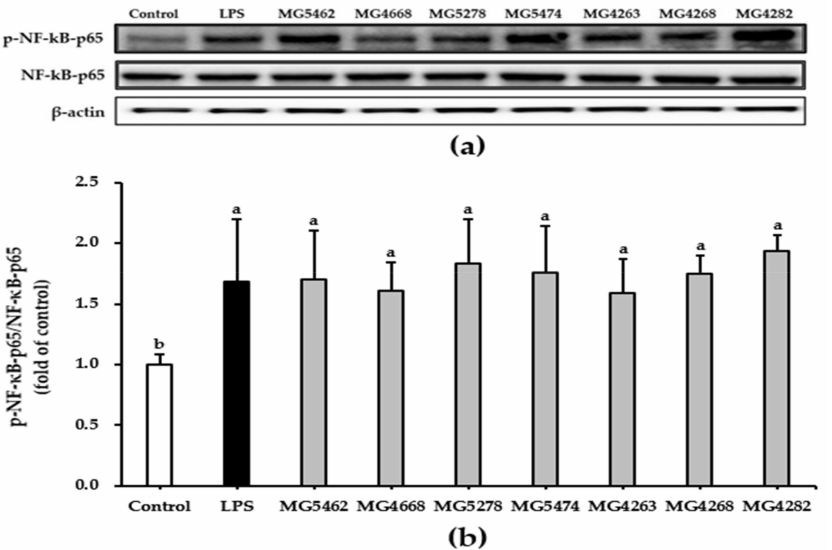
Figure 4. Effect of CFS from LAB strains on NF- κ B activation in RAW264.7 cells. Representative Western blot ( a ) and activation levels of NF- κ B ( b ). Cells were treated with LPS (10 ng/mL) or CFS (5 mg/mL) for 24 h. The NF- κ B activation levels were quantified using densitometry. Data are presented as the mean ± SD of three independent experiments ( n = 3). Different letters indicate significant differences between means at p < 0.05 based on Duncan’s multiple range test.